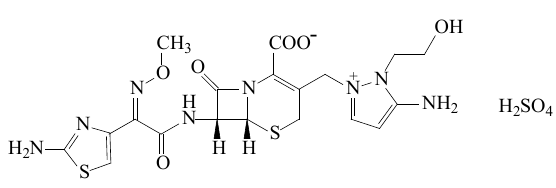
Figure 1. Chemical structure of cefoselis sulphate.